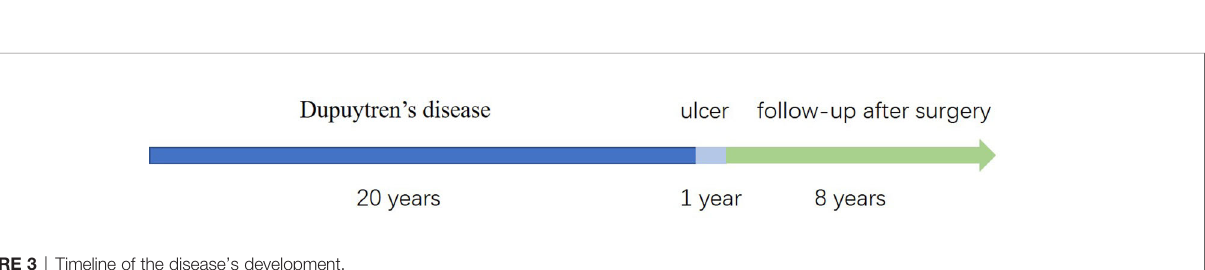
FIGURE 2 | Histopathology of the hand lesion. HE staining of the tissue (panel A was from the edge of the ulcer, panel B was from the ulcer) revealed atypical squamous cell proliferation and horn pearls in the dermis (H&E×100, ×10). Immunohistochemical staining of the biopsy specimen showed (C, D) the squamous cells were positive for pan cytokeratin and negative for vimentin (×100).